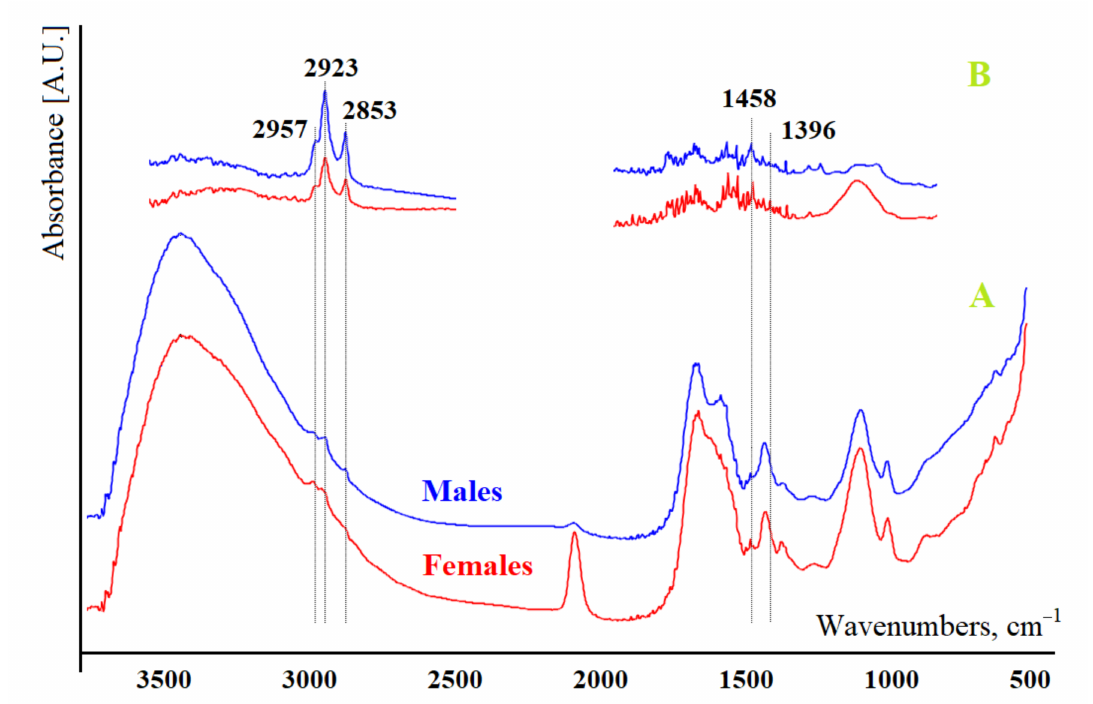
Figure 1. An example of the IR spectrum of the saliva of the control group before extraction ( A ) and after extraction ( B